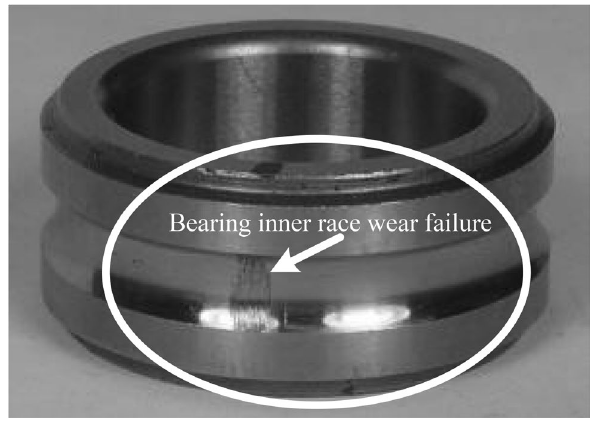
Fig. 5 Bearing inner race wear failure